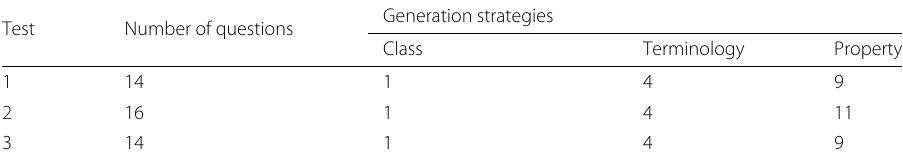
Table 5 Distribution of questions based on the generation strategies